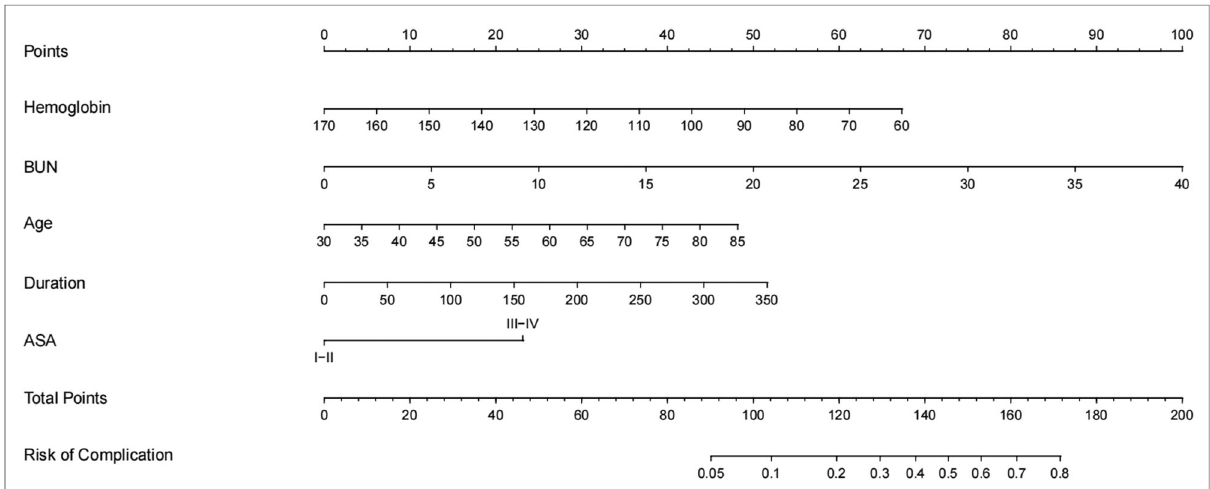
FIGURE 1 A nomogram for predicting complications within 30 days after SBTKA based on independent risk factors. BUN: Blood urea nitrogen; ASA: American Society of